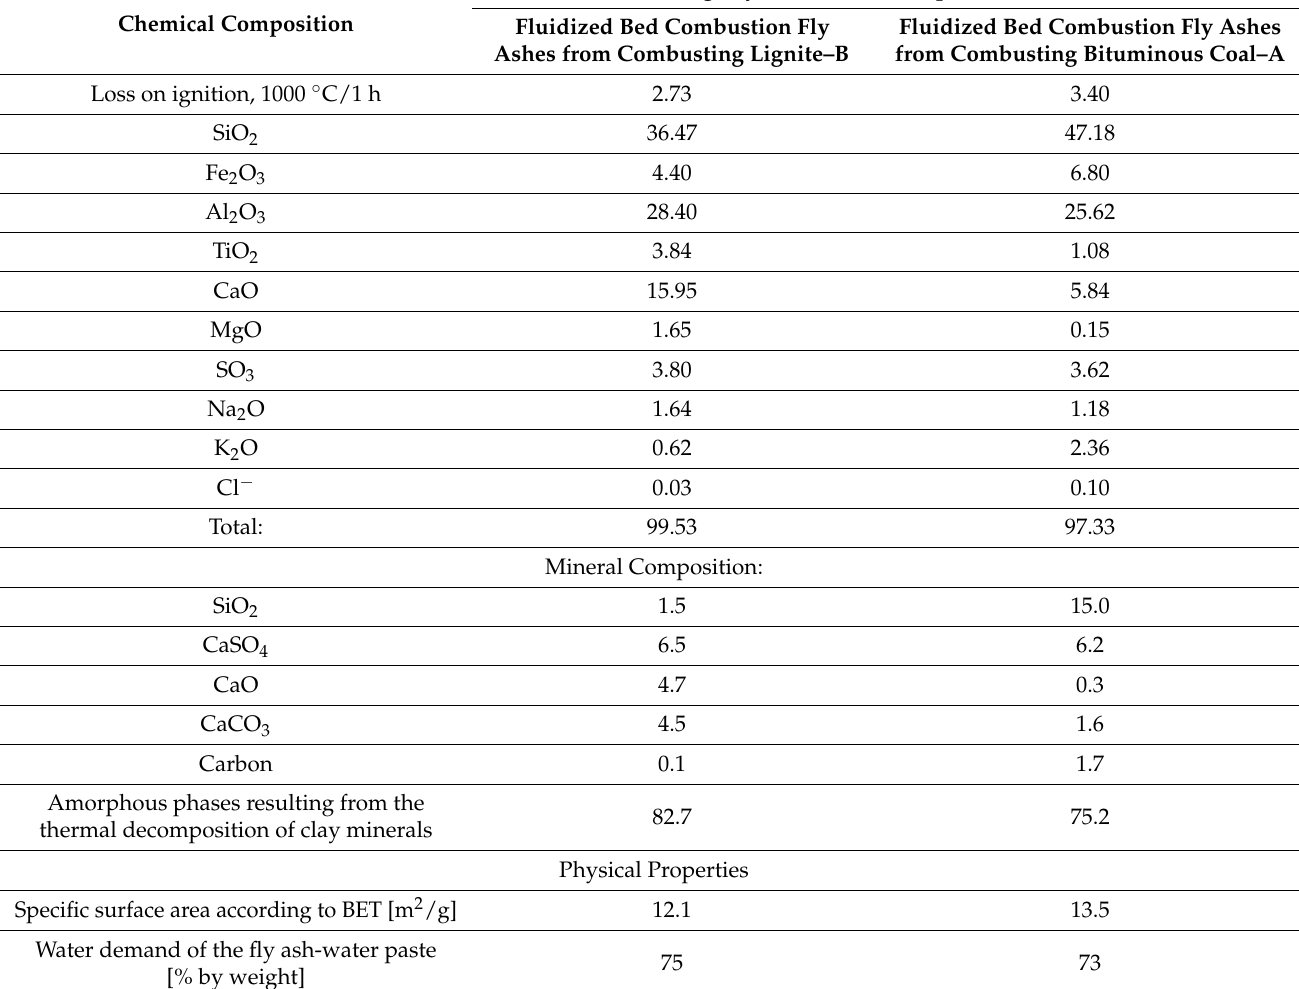
Table 1. Chemical and mineral composition of fluidized bed combustion fly ashes used in the study and their basic physical